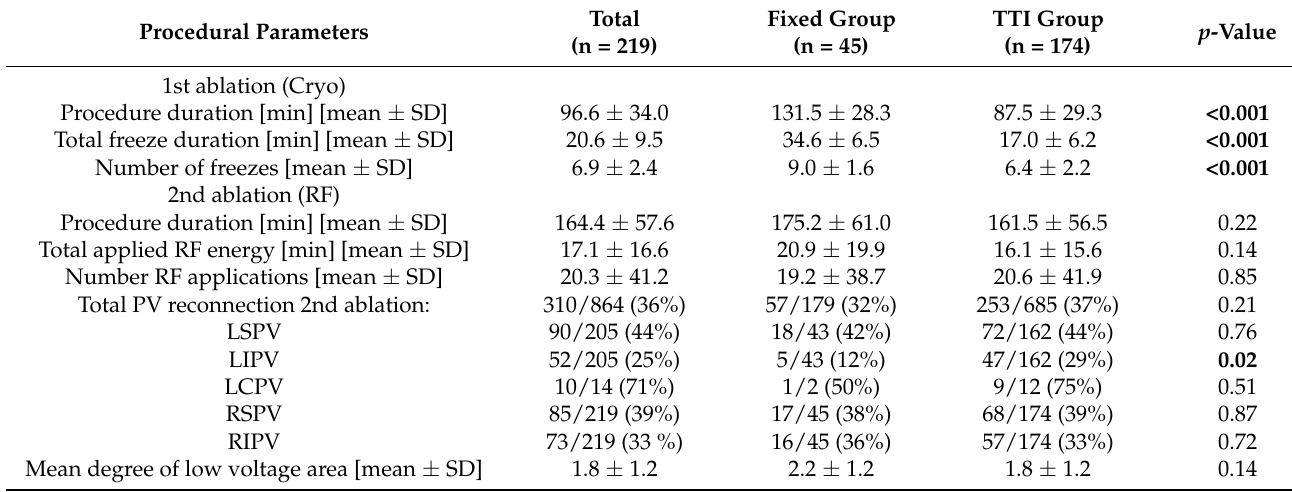
Table 2. Procedural characteristics.